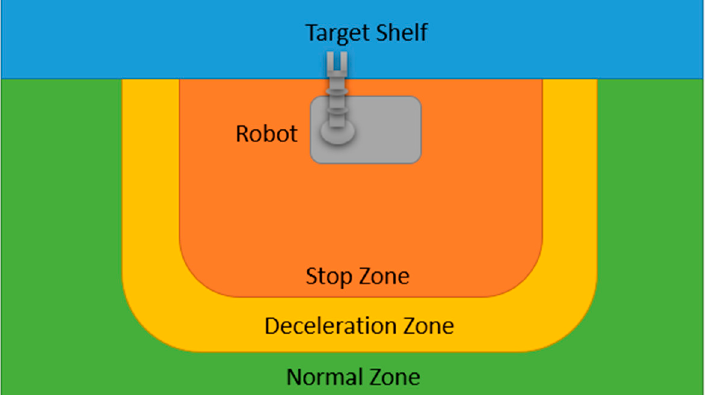
Figure 5. Safety zones around the robot.